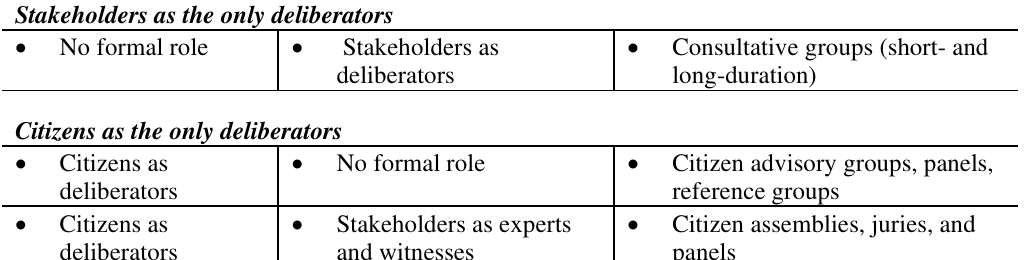
Table 2 —A summary of different design approaches to involving stakeholders